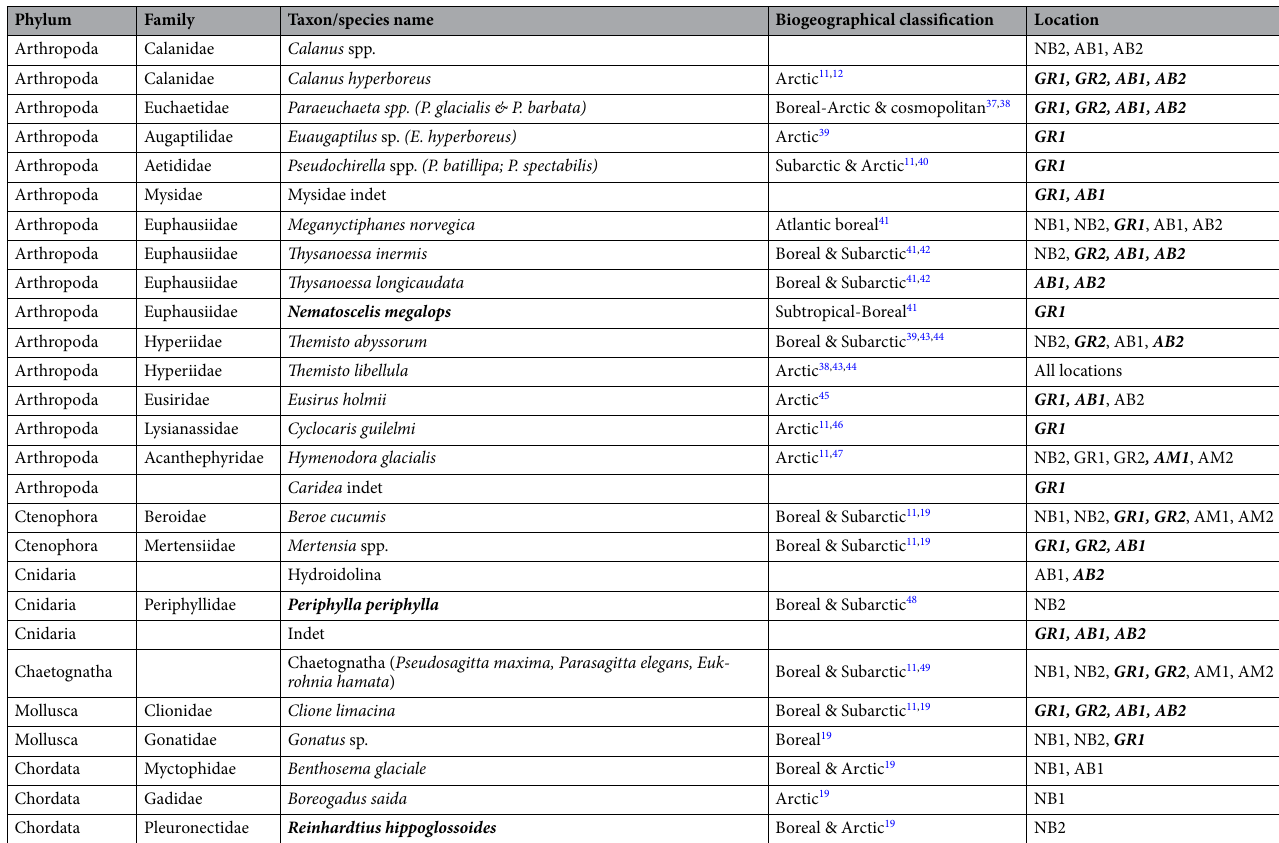
Table 2. Taxa recorded during the survey. Phylum, family and species/taxon names are given with nomenclature consistent with the World Register of Marine Species. In bold print are species for which our study provided the first record from the study area from our knowledge. Biogeographical affinity and sampling location are also shown. Locations where the taxa were sampled only by the macroplankton trawl are shown in bold and italics font. Photographs of the catches are given in Figs.